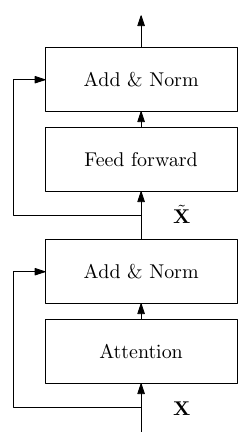
Figure 3. A transformer